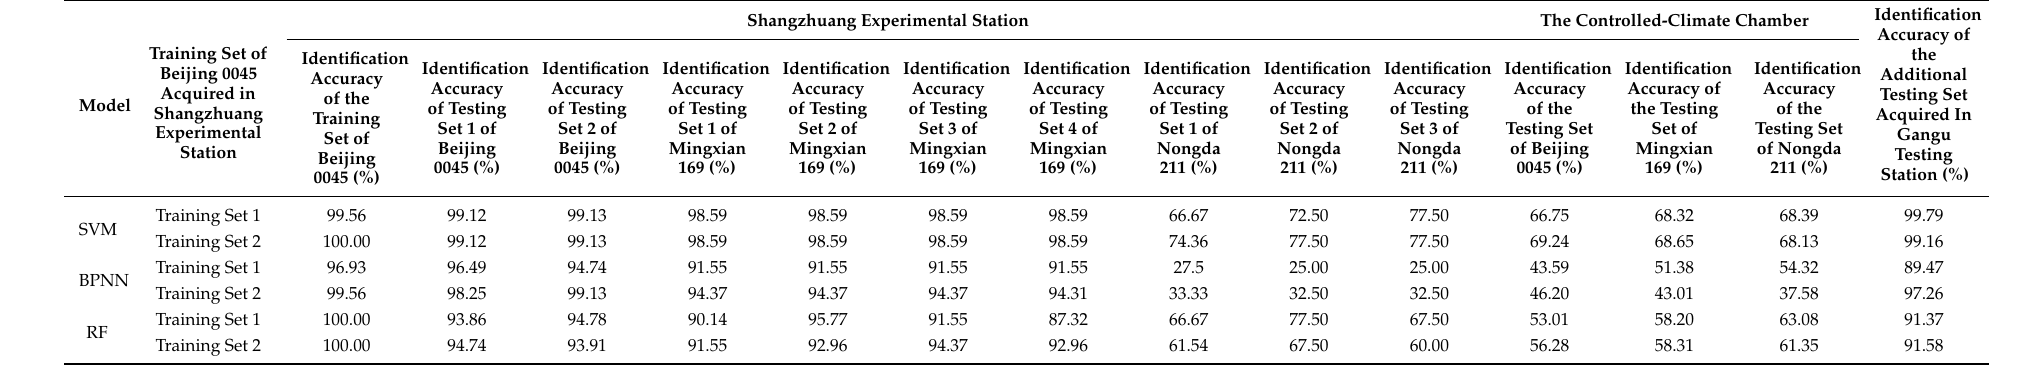
Table 11. Identification results for the individual-variety disease image testing sets acquired in the wheat field in Shangzhuang Experimental Station and under laboratory environmental conditions, and the additional testing set consisting of multi-variety disease images acquired in the wheat field in Gangu Testing Station using the SVM, BPNN, and RF models. These were built based on the different training sets of the variety Beijing 0045 consisting of disease images acquired in the wheat field in Shangzhuang Experimental